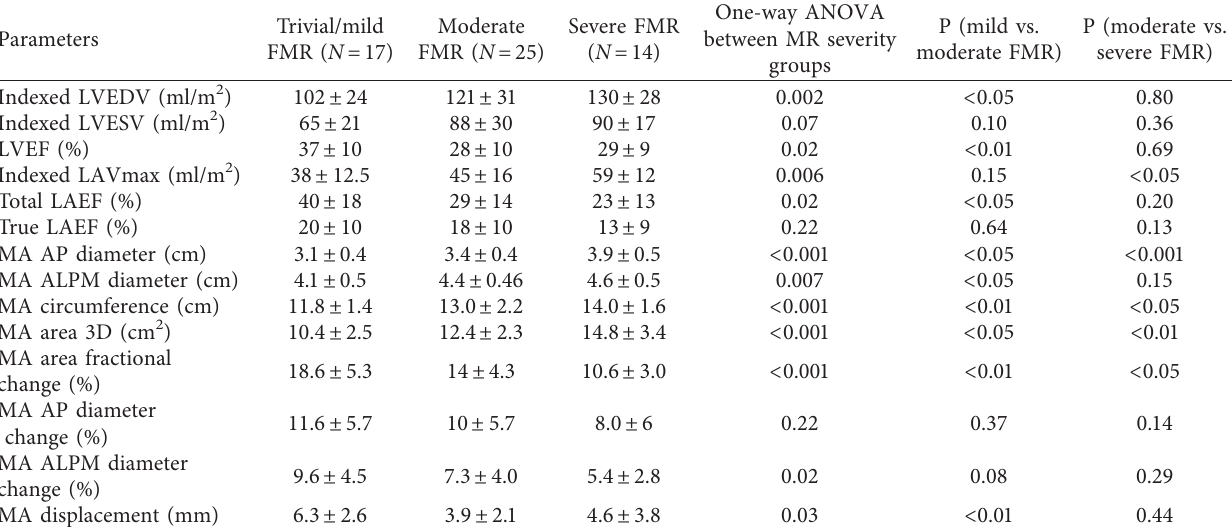
Table 5: Comparison between patients with trivial/mild, moderate, and severe